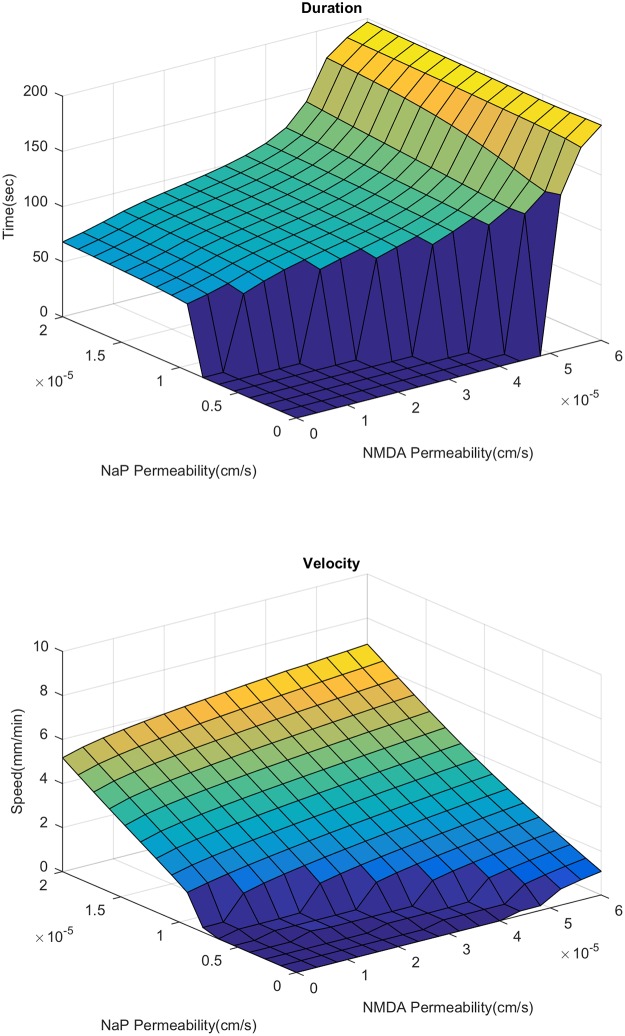
Duration and velocity of spreading depression.Varied over a range of PNaP and PNMDA. Details on the calculation of duration and velocity are provided in S2 Text.